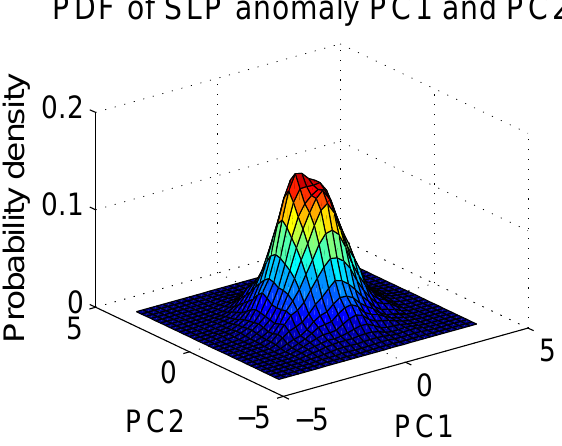
Fig. 3. Gaussian kernel PDF estimate of the leading two JJAS SLP PCs.